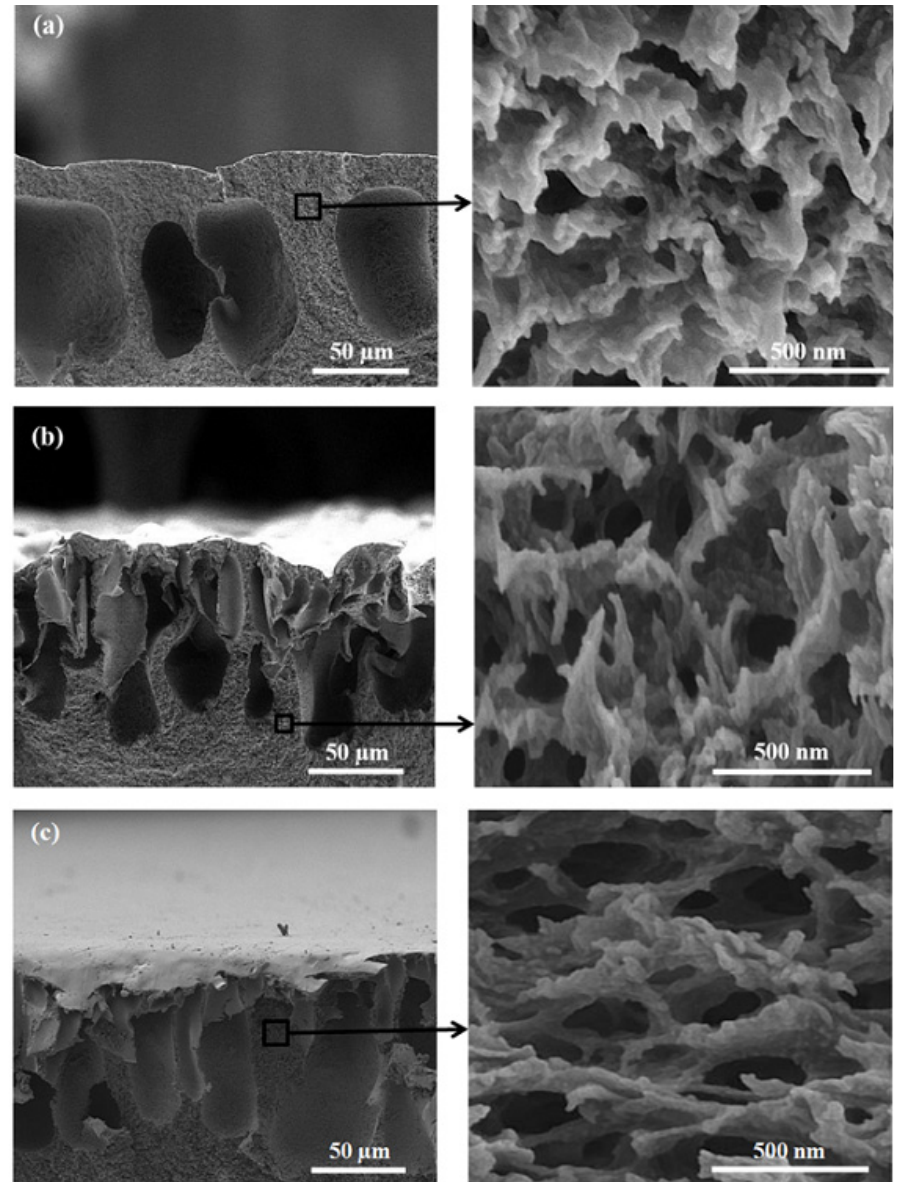
Fig. 4. Cross-section FE-SEM images of prepared membranes: (a) CA, (b) CA/ND (0.5 wt.%), (c) CA/ND-PEG (0.5